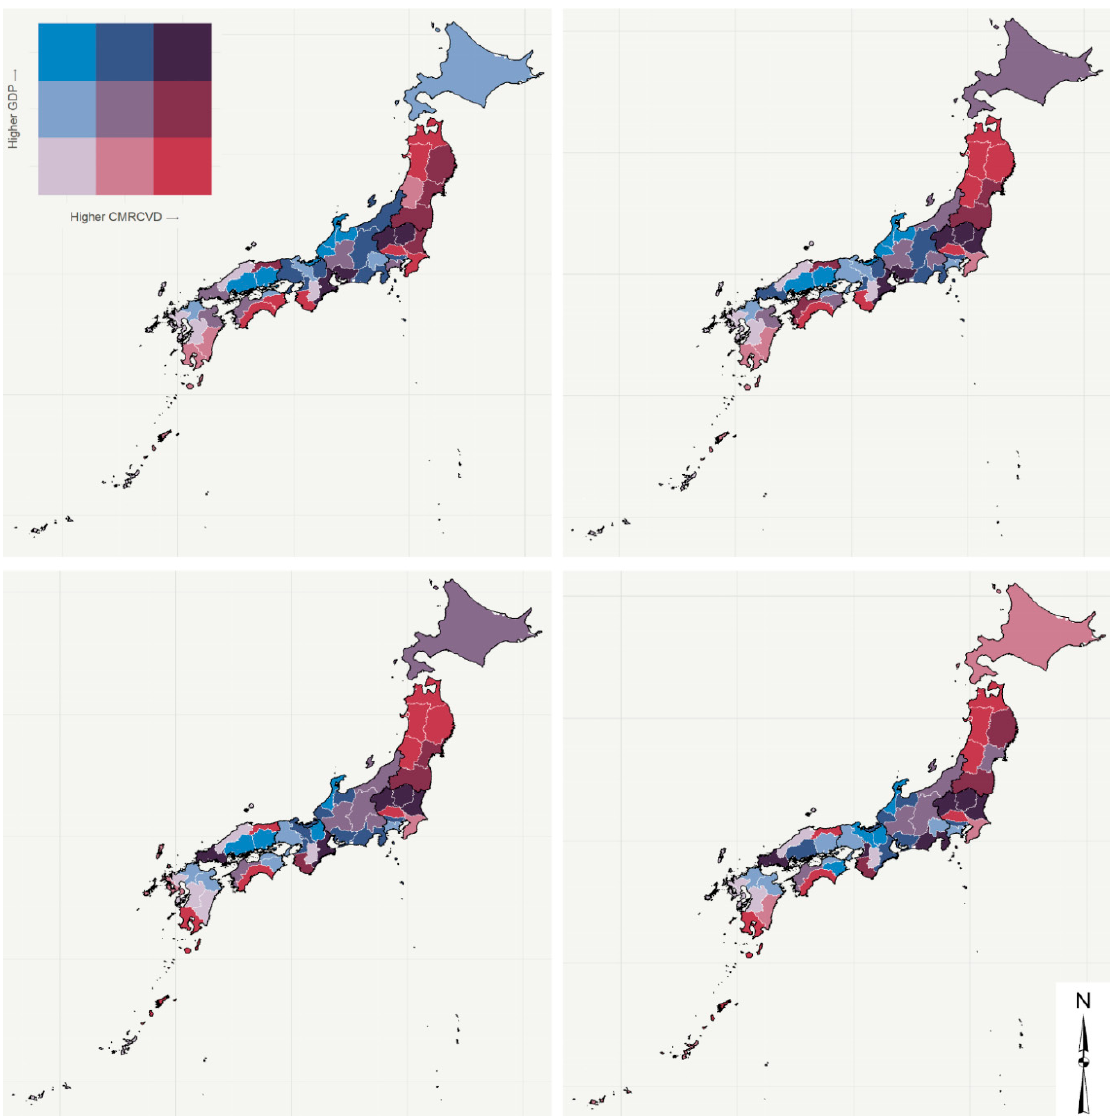
Figure 2. CVD mortality rates vs. GDP per capita, males, prefectures, Japan—time series 1996–2000 ( top left ), 2001–2005 ( top right ), 2006–2010 ( bottom left ), and 2011–2015 ( bottom right ).